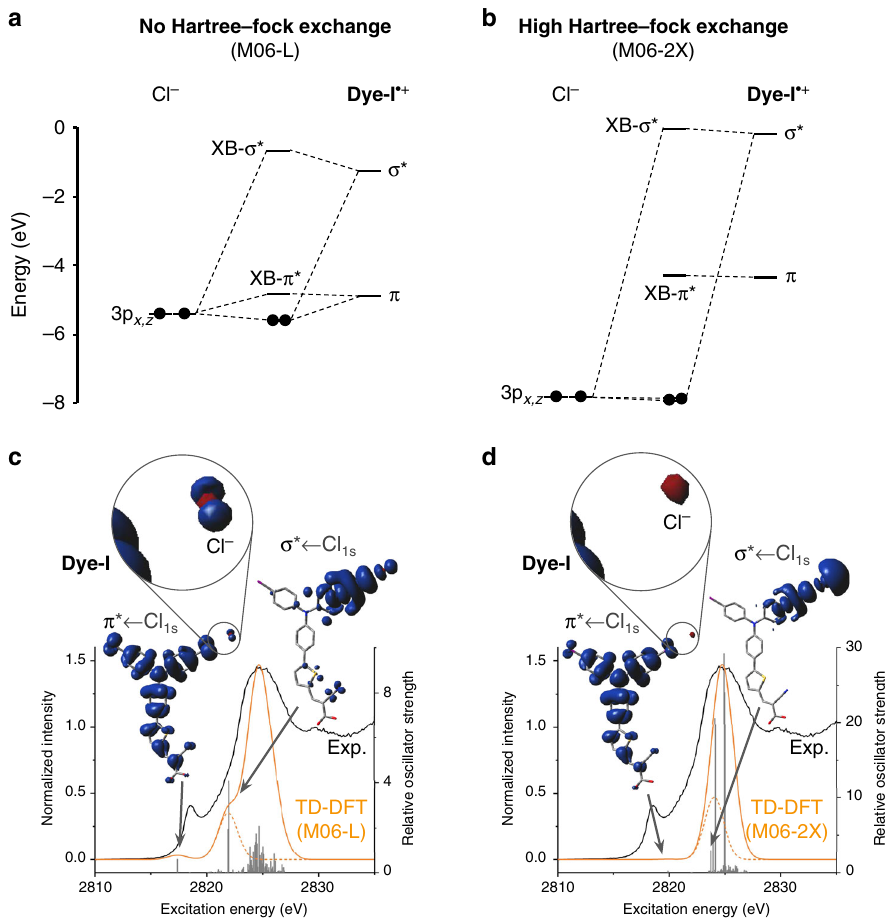
Fig. 4 DFT functional dependence of computational results with Dye-I (cid:129) + ···Cl – . a , b Molecular orbital diagrams describing the orbital mixing involved in the halogen bonding interaction between Cl – and Dye-I (cid:129) + . These molecular orbital diagrams were generated from the β -spin single-electron Kohn-Sham orbital eigenvalues calculated using either the pure meta-GGA functional M06-L ( a ) or the high Hartree-Fock exchange hybrid functional M06-2X( b ) and are simpli fi ed to consider only the orbital interactions resulting in the acceptor orbitals for the XAS pre-edge transitions. c , d TD-DFT simulated XAS spectra (orange lines) calculated using M06-L ( c ) or M06-2X( d ) overlaid on the experimental Dye-I (cid:129) + ···Cl – spectrum (black lines). The indicated pre-edge transitions are visualized with EDDMs as described in the Fig. 3 caption. In order to highlight the pre-edge features resulting from σ - and π -covalency in Dye- I (cid:129) + ···Cl – , truncated versions of the simulated spectrum excluding the high energy Cl 4p ← Cl 1s edge peak transitions were also generated (dotted orange